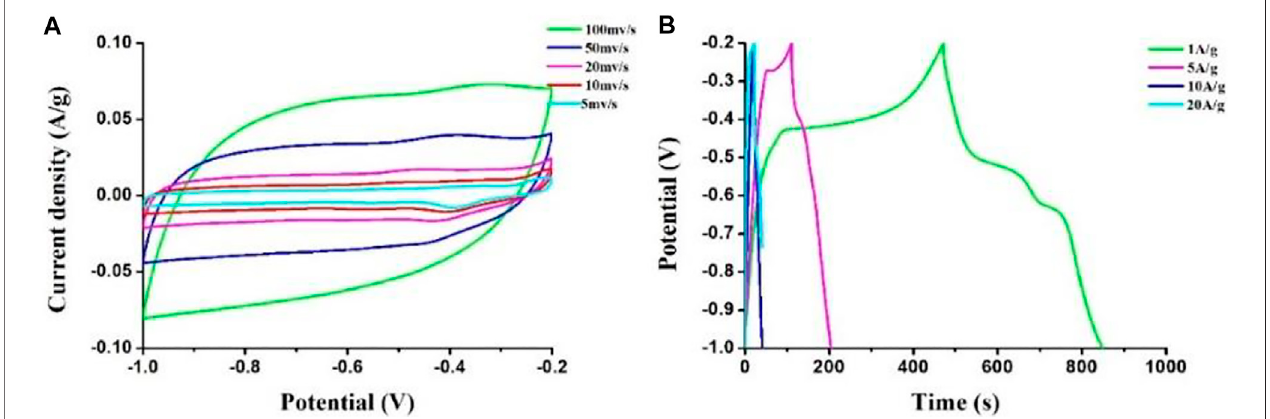
FIGURE 8 | (A) CV curves at different scan rates and (B) GCD curves at different currents of the MnO 2 /HPC composite sample.